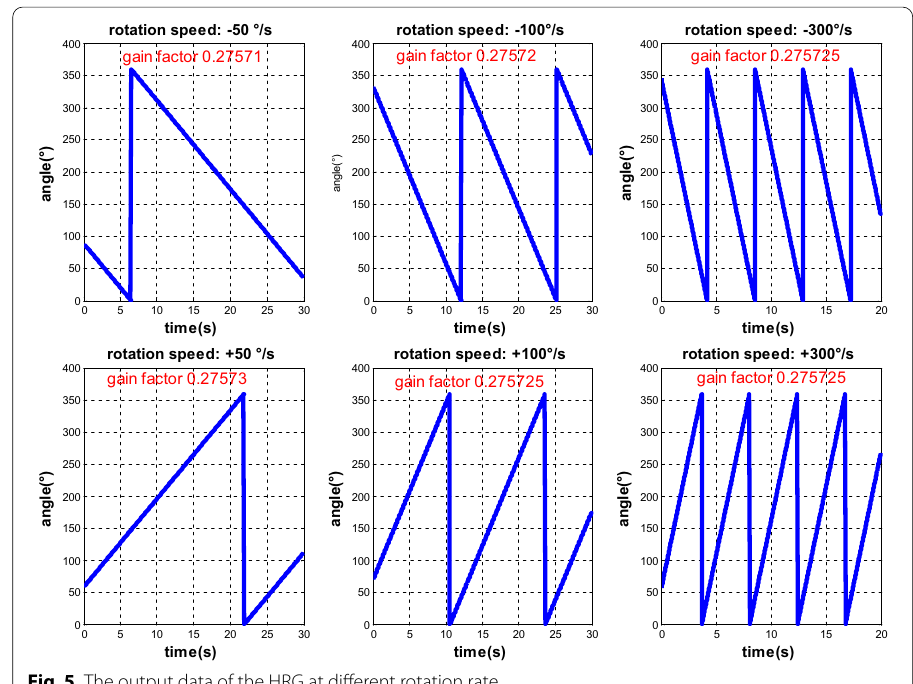
Fig. 5 The output data of the HRG at different rotation rate